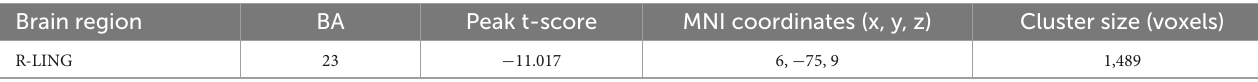
TABLE 6 Significant differences in dFC values of the right V1 between HM patients and HCs. Brain region BA Peak t-score MNI coordinates (x, y,